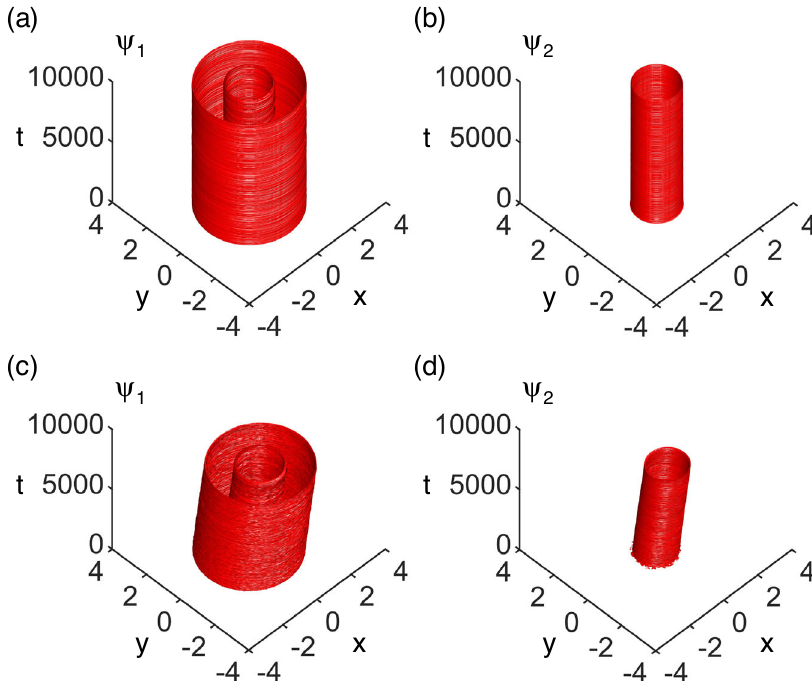
Fig. 6 Temporal evolutions of the bulk solitons. Isosurfaces for the temporal evolutions of the bulk solitons without ( a ), ( b ) and with ( c ), ( d ) noises added to the initial input. The soliton frequencies are ω =